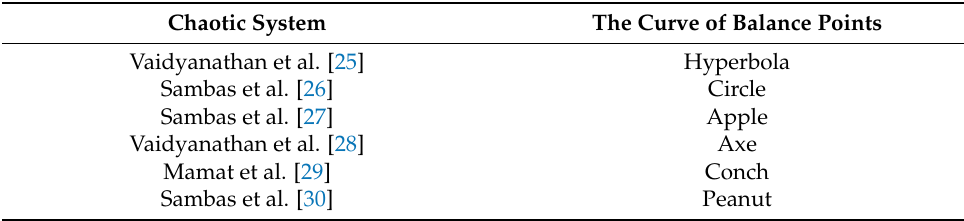
Table 1. Chaotic systems with special curves of balance points. Chaotic System The Curve of Balance